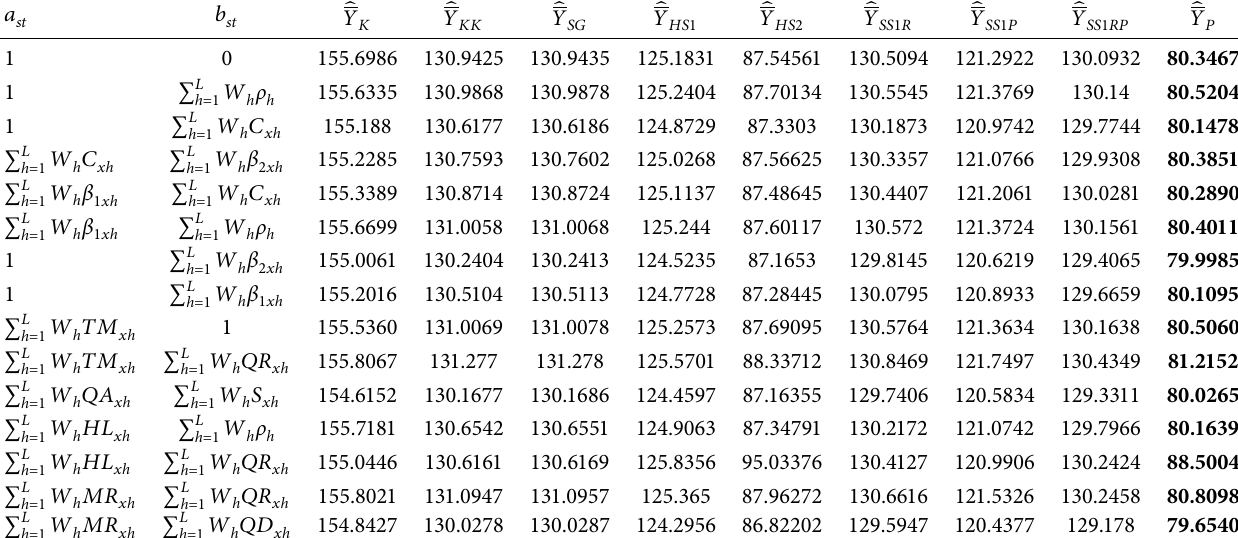
Table 8: Minimum MSEs of different estimators based on the simulation study ( n �